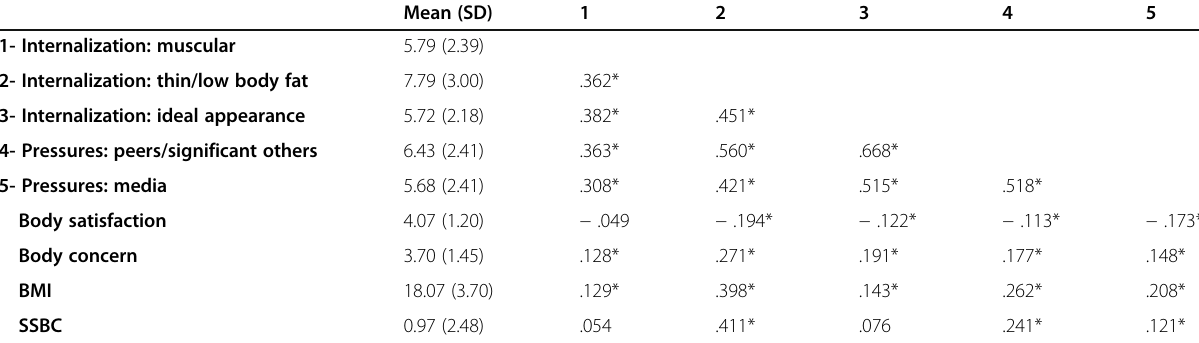
Table 4 Intercorrelations between SATAQ-4R-Female subscales, body satisfaction, body concern, BMI, and SSBC in Brazilian girls